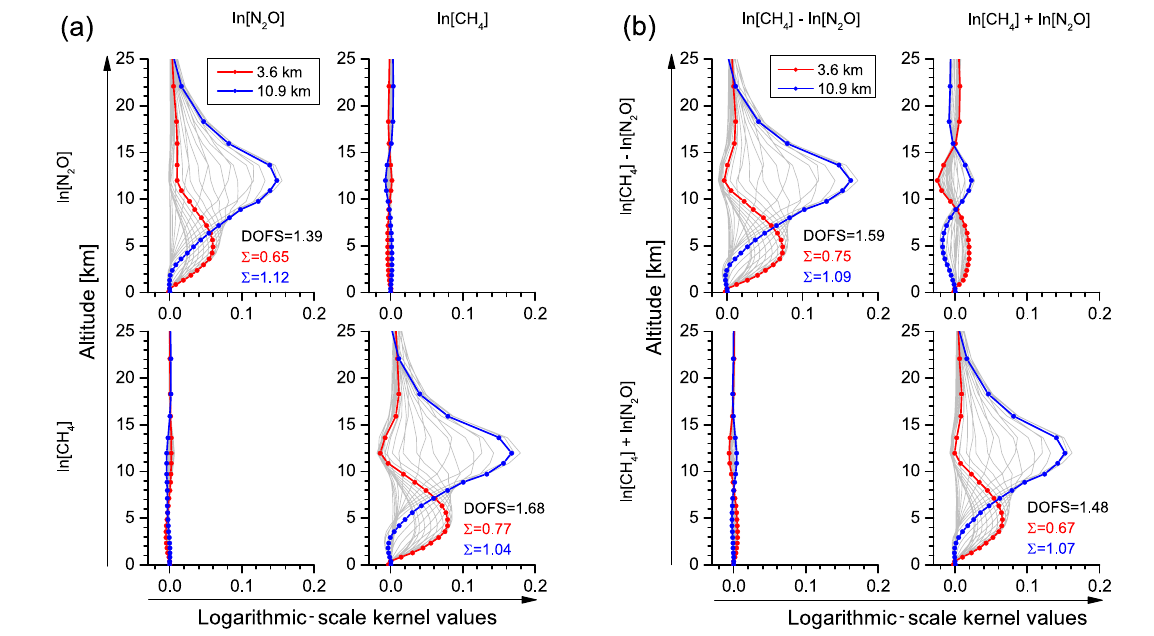
- - Figure 2. Example of an averaging kernel for an observation over the mid-latitude site of Lindenberg (52 ◦ N) on 30 August 2008 (satellite nadir angle: 43 . 7 ◦ ; surface skin temperature: 292.3K; precipitable water vapour: 31.8mm): (a) for the state vector {ln [ N 2 O ] , ln [ CH 4 ] } o n and (b) for the state vector ln [ CH 4 ]− ln [ N 2 O ] , ln [ CH 4 ]+ ln [ N 2 O ] . 2 Table 2. Overview on the different N 2 O and CH 4 remote sensing products discussed in this